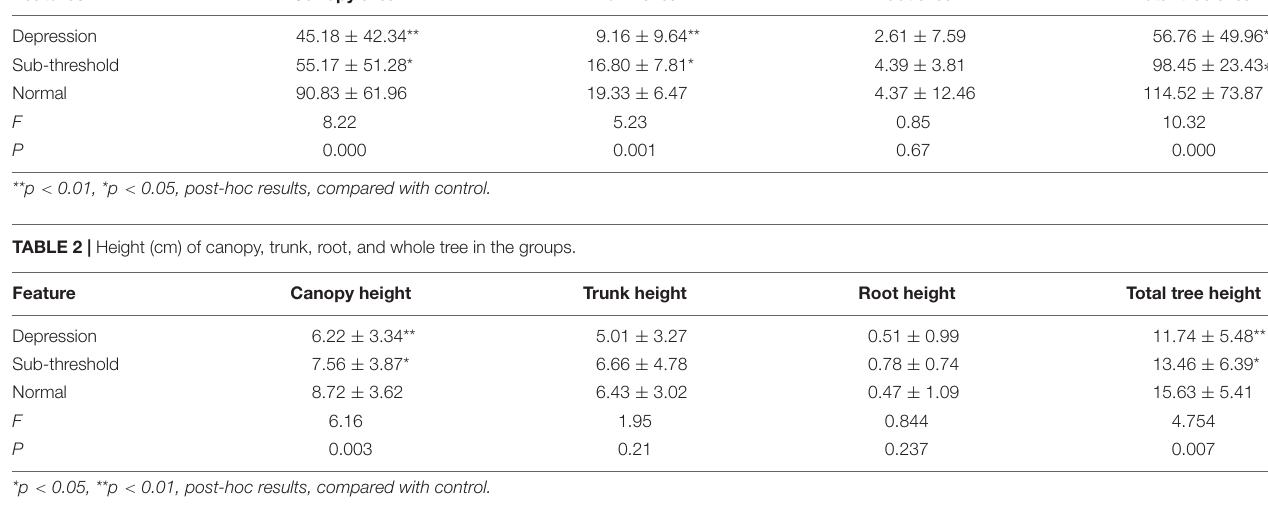
statistically significant between the three groups ( p < 0.01). The depression group, the control group, and the sub-threshold group show a statistically significant difference in the width of the trunk as well ( p < 0.01). It was not significantly different in the width of the trunk between the depression group and the sub-threshold group ( Table 3 ). The ratios of canopy width, trunk width to the root width were not significantly different either ( Figure 6 ).